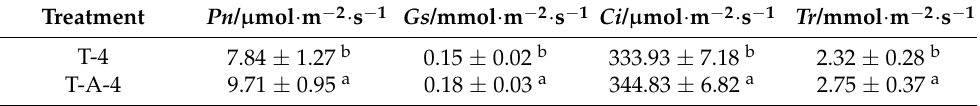
Table 2. Effect of exogenous application of ALA on photosynthetic gas exchange parameters of tea leaves under cold